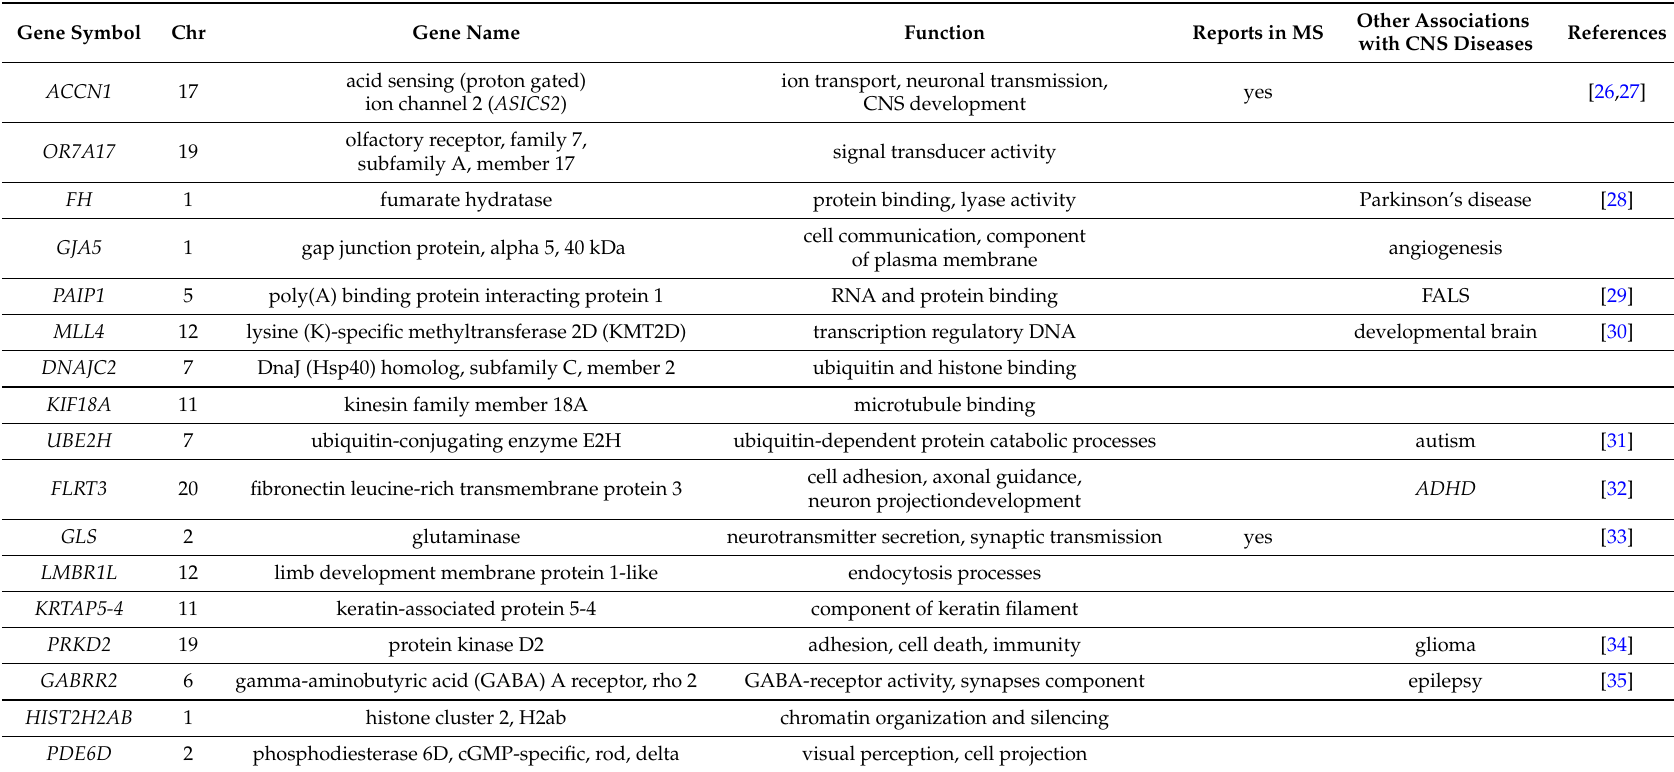
Table 3. Genes DC at the level of 0.05 in the MS vs. HC comparison in at least 2